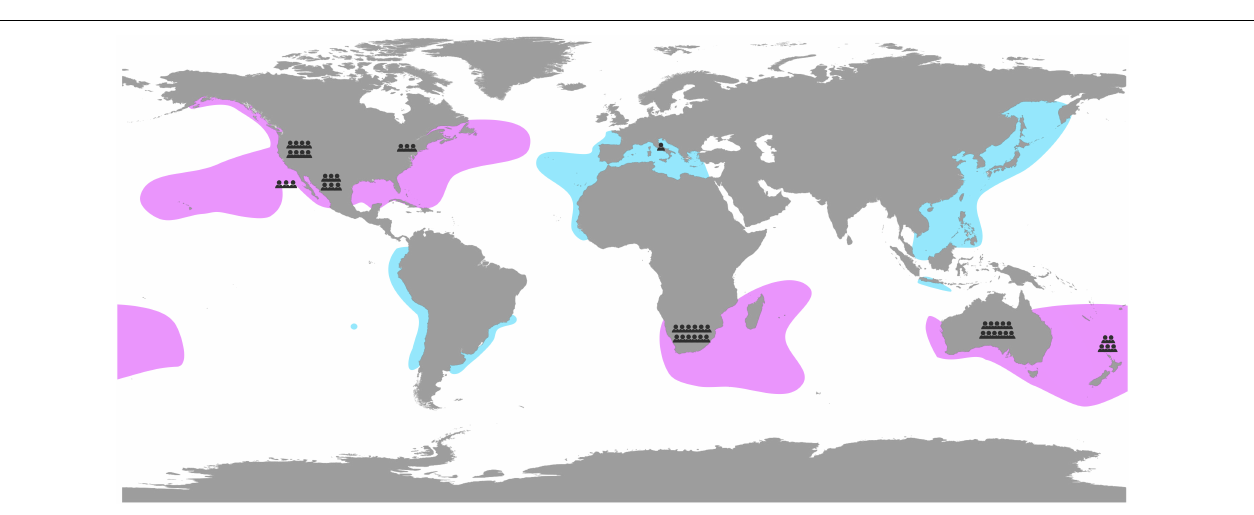
FIGURE 2 | White shark ( Carcharodon carcharias ) distribution based on known aggregations and tracking data (pink) and confirmed occurrence (blue; also representing lesser-known regions). White shark scientists and managers contributing to this study are represented by small torso located where they have most worked on white